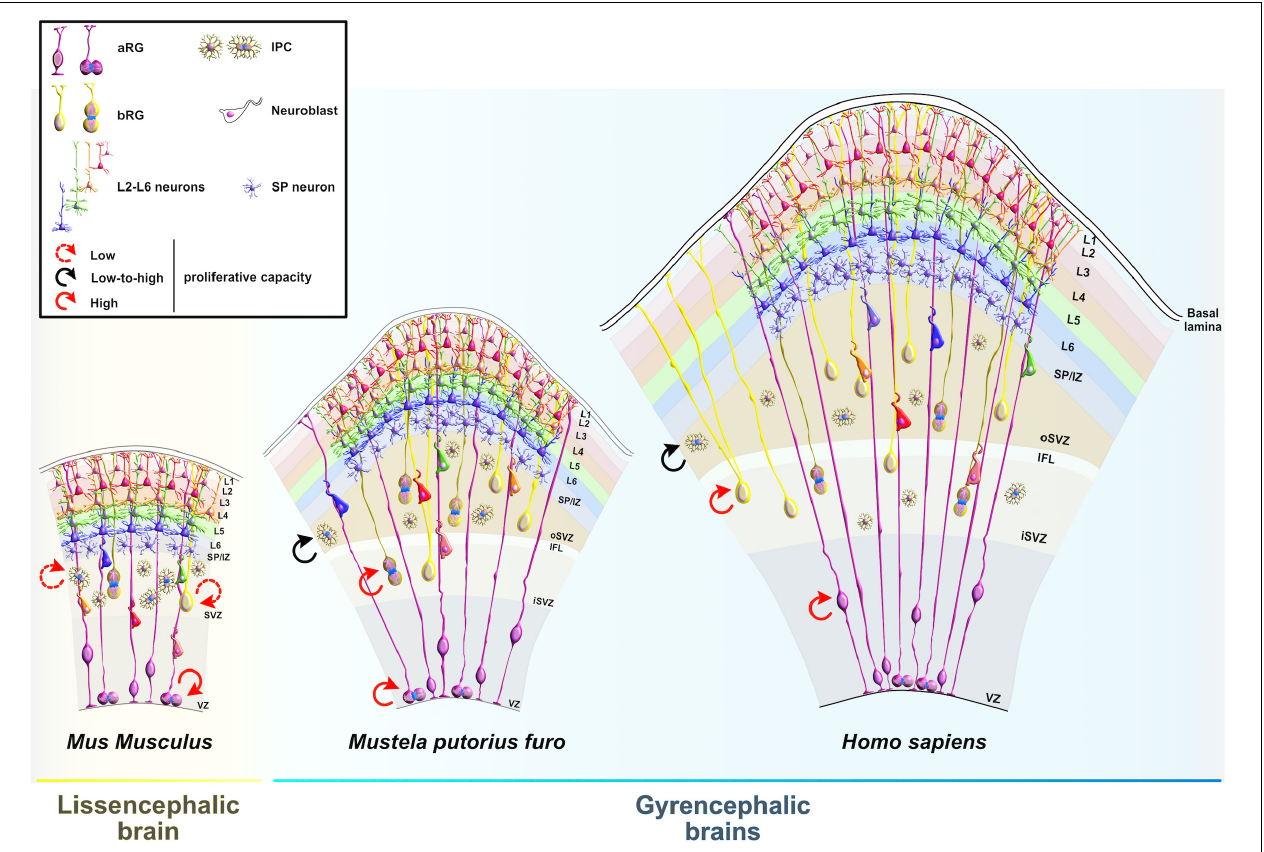
FIGURE 11 | Expansion of the neocortex. Mice have smooth and small (lissencephalic) neocortex, whereas ferrets and humans have folded and expanded (gyrencephalic) neocortex. The evolutionary expansion of the neocortex and vast species–species differences are linked to the expansion and specialization of the subventricular zone (SVZ) into inner SVZ and outer SVZ, accompanied with the substantial expansion of the basal progenitors, particularly basal radial glia. Although apical radial glia have high proliferative capacities across species (red arrow), the evolution of basal radial glia is associated with the impressive increase in their number, complexity, variety, and proliferative capacities (red arrow) in gyrencephalic species. In lissencephalic brains, intermediate progenitor cells represent the largest proportion of basal progenitors and, like basal radial glia, have low proliferative capacity (broken red arrow). In gyrencephalic brains, intermediate progenitor cells have lower relative abundance compared to basal radial glia and are characterized by a wide range of proliferative capacities (black arrow). aRG, apical radial glia; IPC, intermediate progenitor cell; bRG, basal radial glia; VZ, ventricular zone; SVZ, subventricular zone; iSVZ, inner SVZ; IFL, inner fiber layer; oSVZ, outer SVZ; SP/IZ, subplate/intermediate zone; L1–L6, layers